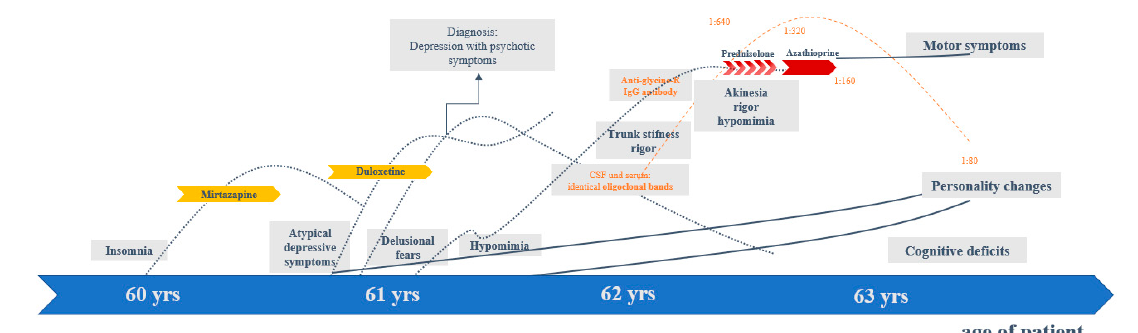
Figure 1. Clinical course. Abbreviation: CSF, cerebrospinal fluid; yrs, years.